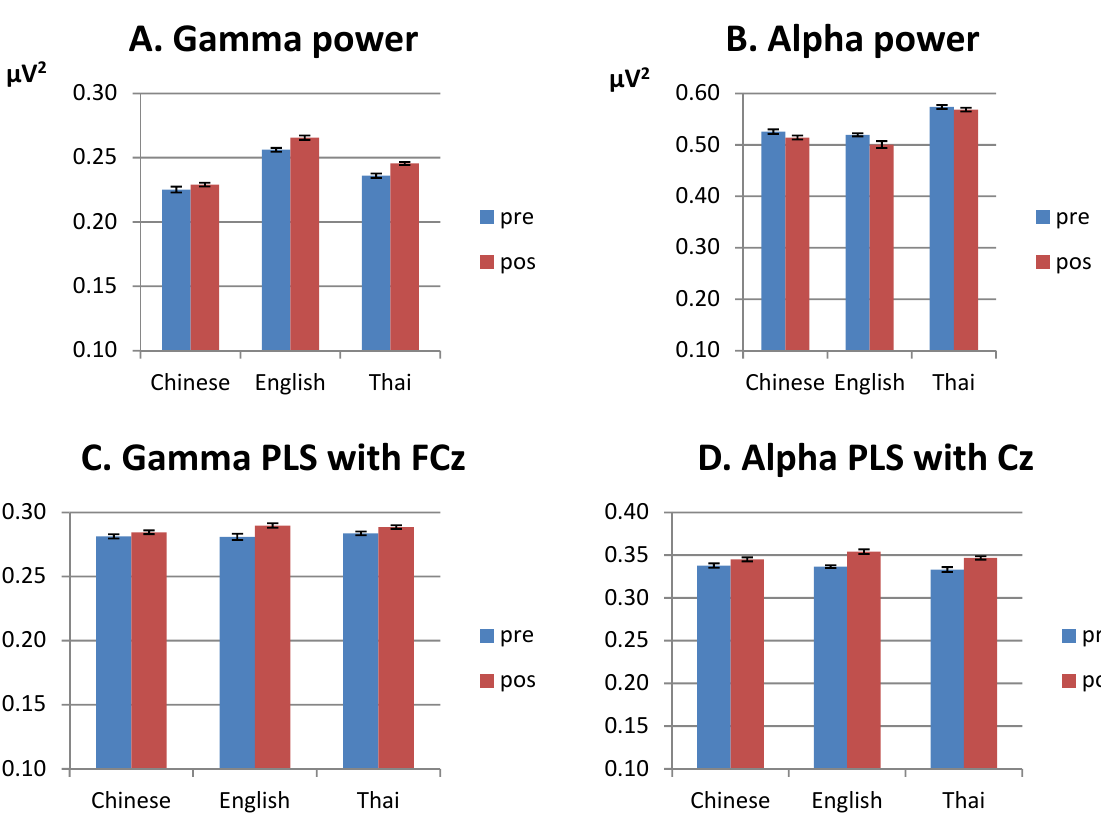
Figure 4. Mean for lateral electrodes for the three language groups, before and after training. ( A ) gamma-band power, 200–400 ms after stimulus onset; ( B ) alpha-band power, 100–500 ms after stimulus onset; ( C ) gamma-band phase synchrony (PLS) with FCz, 200–400 ms after stimulus onset; ( D ) alpha-band phase synchrony (PLS) with Cz 100–500 ms after stimulus onset. Note that the y -axis starts at 0.1 and that different scales are used for the different subfigures. Error bars are standard